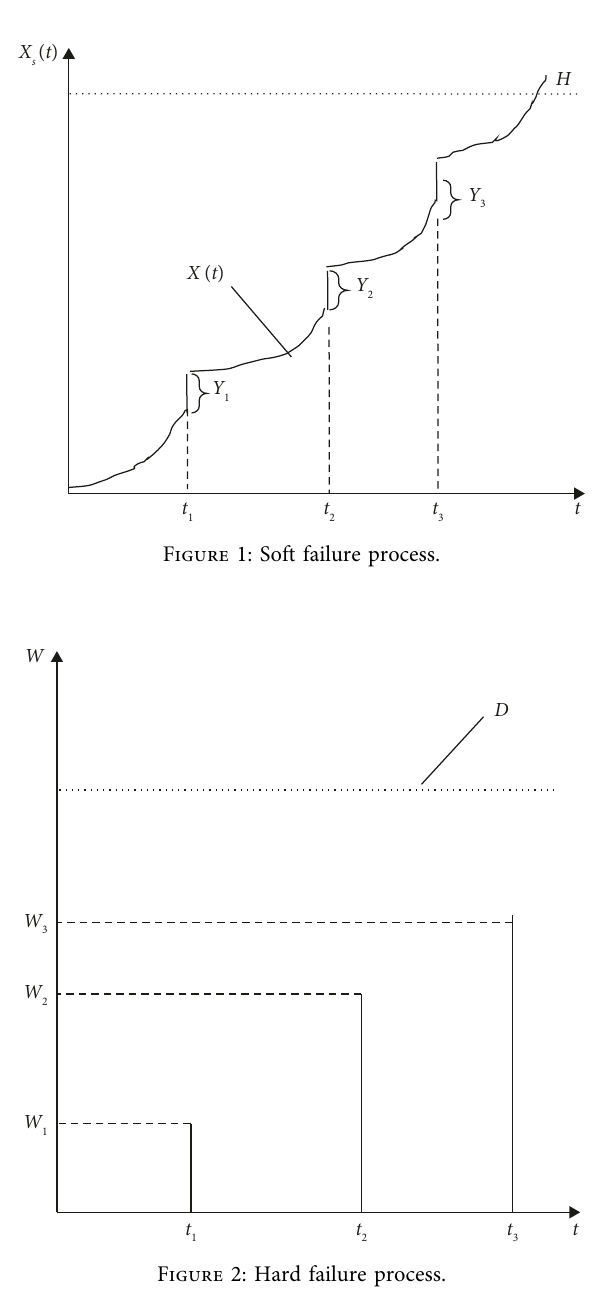
Figure 2: Hard failure